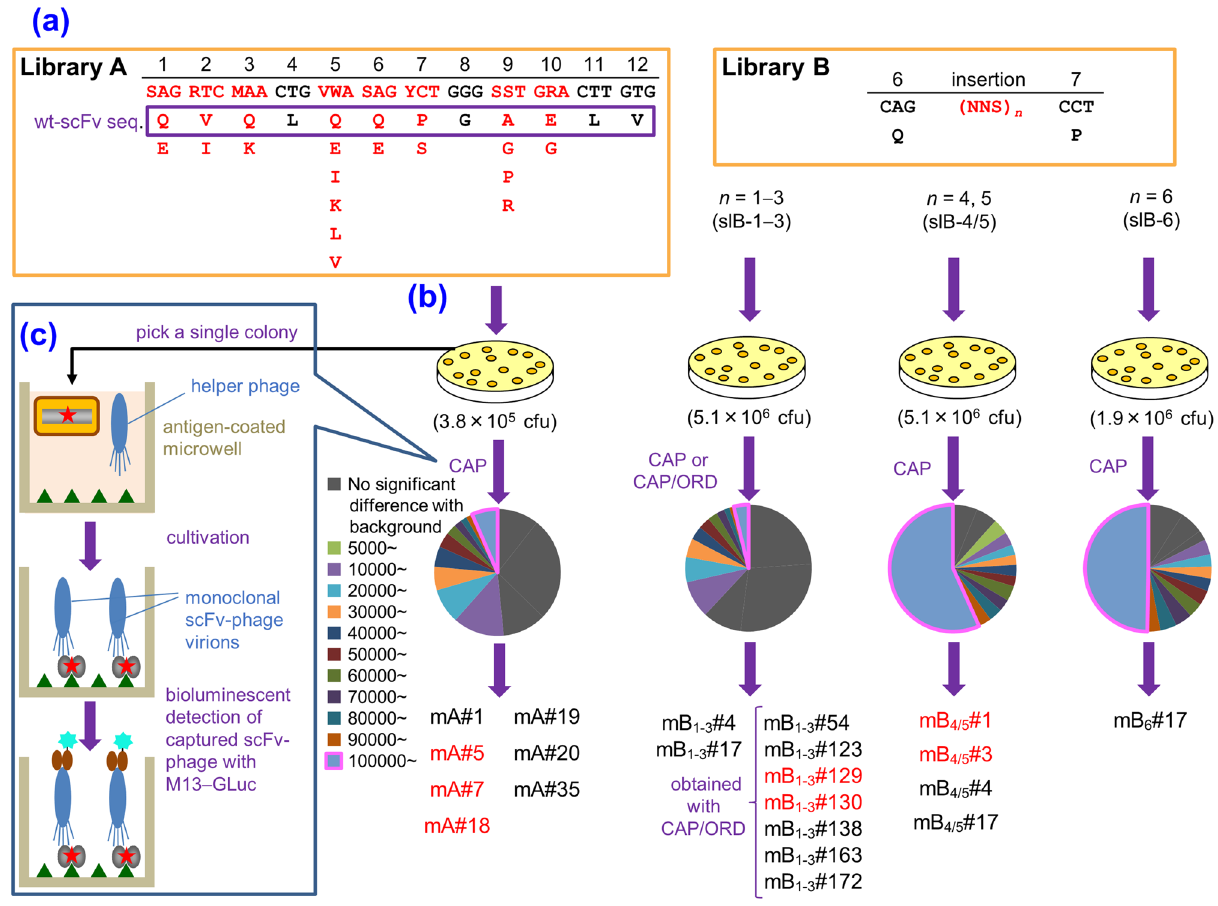
Figure 2. Workflow of the present study. ( a ) Design of the libraries A (left) and B (right), based on the V H - FR1-targeted site-directed randomization and insertion, respectively. The library A was composed of scFv sequences, whose codons for amino acids at the positions 1–3, 5–7, 9, and 10 were degenerated to encode 2–6 kinds of predefined residues as indicated. The library B involved the scFv sequences, in which extra 1–6 amino acid residues were inserted between the positions 6 and 7 using the (NNS) n degenerated codons ( n = 1–6): this was divided into three sublibraries slB-1–3, slB-4/5, and slB-6. ( b ) Screening of the libraries with CAP or CAP/ ORD system. E. coli TG1 cells were transformed with one of the scFv libraries (A, slB-1–3, slB-4/5, or slB-6) to generate bacterial libraries with similar transformant numbers (0.38–5.1 × 10 6 cfu), which were each grown on agar plates. Among the resulting colonies, 4,700 were randomly selected and subjected to CAP using 50 microplates: for each plate, 94 microwells were used for inoculating colonies and 2 for background without colonies but with KM13 helper phage. Top 40 scFv-phage clones that showed higher RLU (> 100,000 RLU) were analyzed for binding to cortisol with competitive ELISA 7 . For slB-1–3, top 188 clones were also subjected to ORD. Then, 40 (after CAP) or 24 (after CAP/ORD) scFv-phages that afforded higher sensitivity (as the midpoint) than wt-scFv were converted to the soluble-form scFvs for examining the affinities. The pie charts show the distribution of luminescent signal (RLU) detected for each single microwell in CAP screening. The background RLU (mean ± SD; n = 100) of each library was varied between microplates as follows: 2758 ± 1909 (A), 3329 ± 3211 (slB-1–3), 507 ± 928 (slB-4/5), 679 ± 2500 (slB-6). ( c ) Summary of CAP system 7 . Bacterial clones are individually cultured in microwells containing the helper phage. Therein, each clone propagates and produces scFv-phages without competing with different clones. Antigen-specific scFv-phages bind the pre- immobilized antigen and are detected with a bioluminescence assay using an in-house-prepared fusion protein combining anti-M13-phage scFv and Gaussia were pooled (slB-1–3) for transformation and the libraries with four- and five-residue insertions (sIB-4/5) and with six-residue insertion (sIB-6) were separately transformed. The theoretical combinatorial diversities of the libraries were 8.42 × 10 3 , 3.36 × 10 6 , 6.40 × 10 7 , respectively (Fig. 2b). Among the transformant colonies, 4,700 clones of the resulting bacterial sublibraries, each containing 1.9–5.1 × 10 6 cfu transformants, were subjected to CAP or CAP coupled with off-rate dependent selection (ORD) system (Fig. 2b). In ORD, the scFv-phage clones recovered from CAP were individually re-propagated in different cortisol-immobilized microwells containing host bacteria. The scFv-phages captured via the cortisol residues therein were incubated with free cortisol, to facilitate removal of faster off-rate phages from the microwells as soluble complexes with the free cortisol (see Supplementary Fig. S1). Examination of approximately 40 clones from each sublibrary, which were selected from